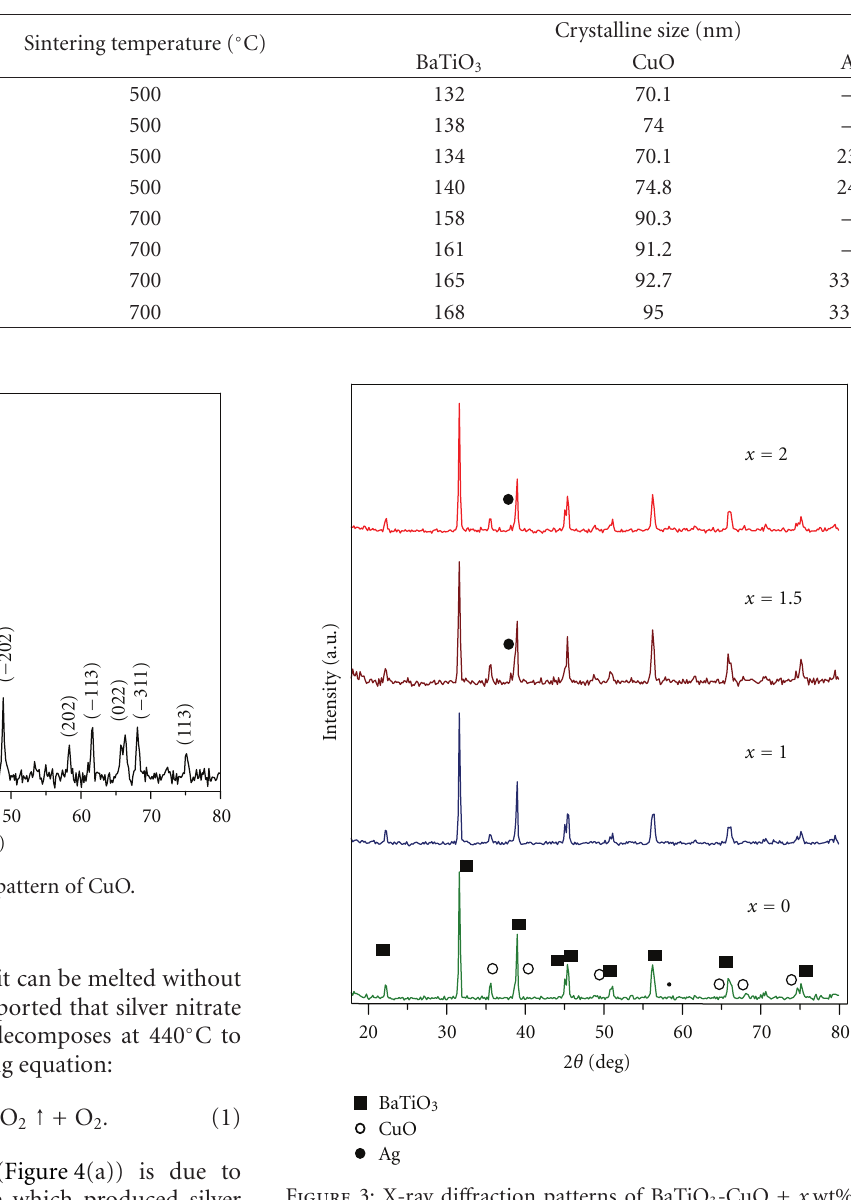
Figure 3: X-ray di ff raction patterns of BaTiO 3 -CuO + x wt% Ag samples sintered at 700 ◦